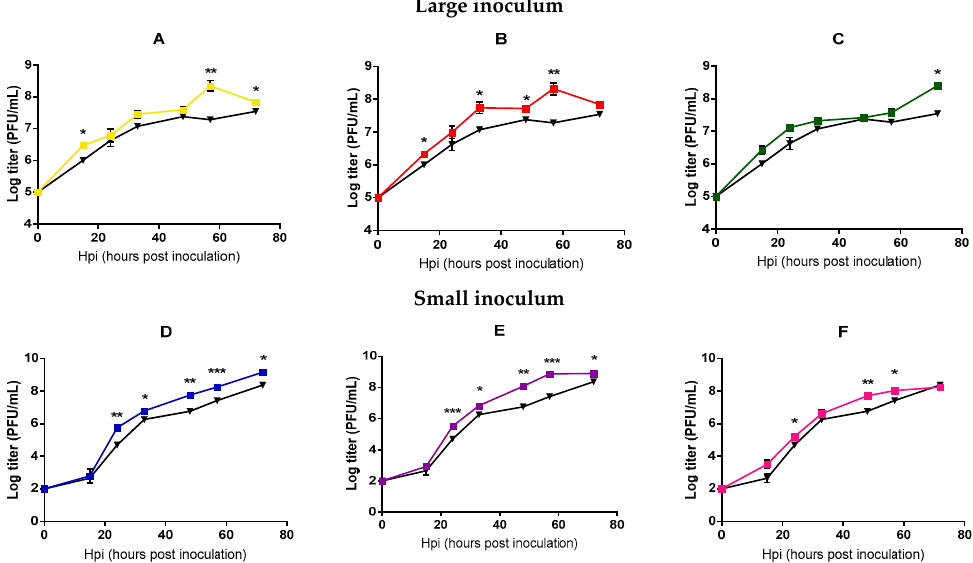
Figure 2. Mycobacteriophages growth curves of the founder and evolved lines. Founder: Black. Large inoculum: ( A ) Yellow, ( B ) red, ( C ) green. Small inoculum: ( D ) Blue, ( E ) purple, ( F ) pink. Dots show the average titer at each time point and error bars indicate the SEM ( n = 3). *: p < 0.05, **: p < 0.005, ***: p <